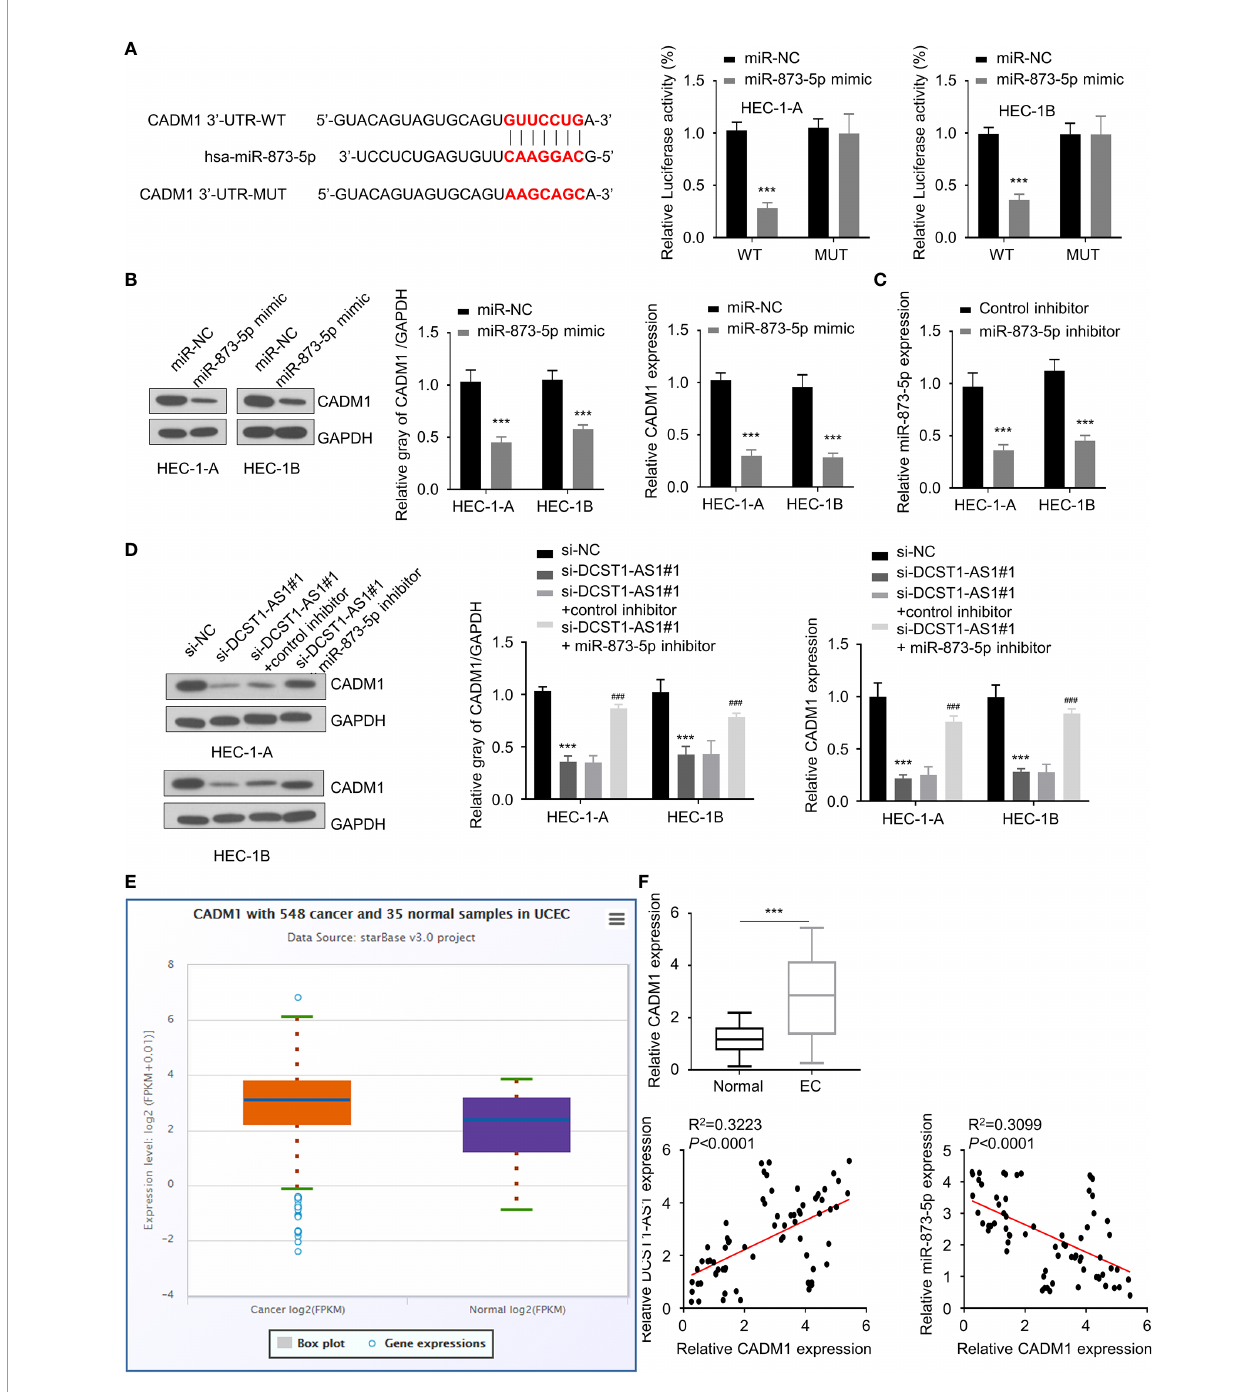
FIGURE 5 | Knockdown of lncRNA DCST1-AS1 decreases cell adhesion molecule 1 (CADM1) expression via sponging miR-873-5p. (A) Predicted and mutant (lower panel) sequence alignments of miR-873-5p with CADM1 3 ′ -UTR sequence. Luciferase reporter assays showed that miR-873-5p signi fi cantly reduced luciferase activity of WT CADM1, but mutation of the miR-873-5p binding site abrogated the inhibitory effects of miR-873-5p (right panel). (B) The mRNA and protein levels of CADM1 in EC cells transfected with miR-873-5p mimic or control mimic were examined using qRT-PCR assay and Western blot analysis. (C) The expression of miR-873-5p in EC cells transfected with miR-873-5p inhibitor or control inhibitor. (D) HEC-1A and HEC-1B cells were transfected as indicated, and the mRNA and protein expression of CADM1 was investigated using qRT-PCR and Western blot analysis. (E) Comparison of CADM1 expression in EC tissues ( n = 548) and normal tissues ( n = 35) (ENCORI database). (F) The mRNA expression of CADM1 in 70 pairs of EC and adjacent normal tissues was checked using qRT-PCR assay. Spearman ’ s correlation analysis was used to analyze the relationship between CADM1 expression and DCST1-AS1 or miR-873-5p expression. *** P < 0.001. ### P < 0.001, compared with si-DCST1-AS1#1